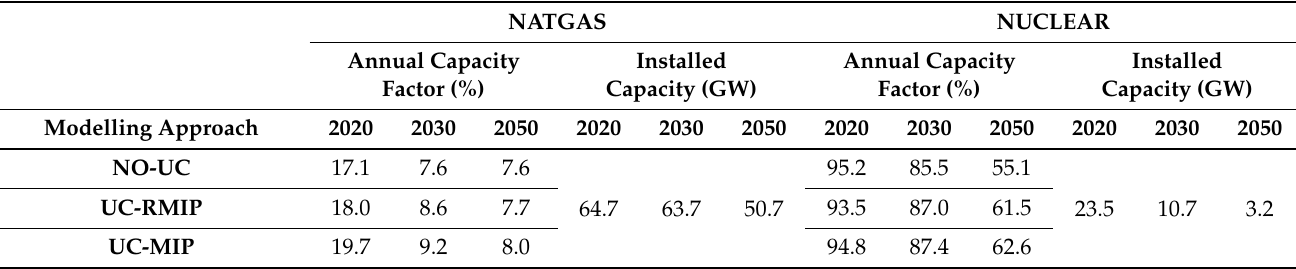
Table 4. Influence of UC modelling approach and year in annual capacity factor of electricity-only thermal generation units for different